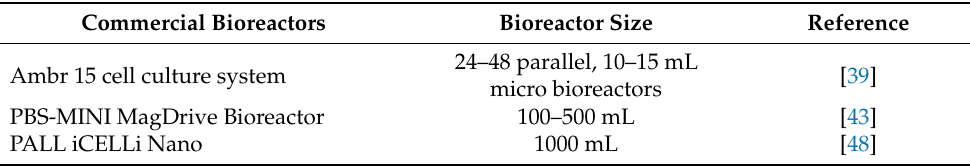
Table 2. Commercial bioreactors used for cell therapy